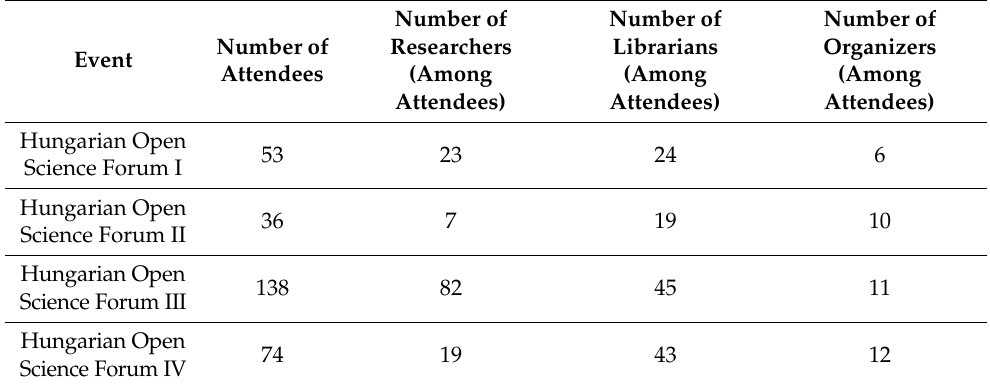
Table 4. Number of attendees of the Hungarian Open Science Forum events broken down by